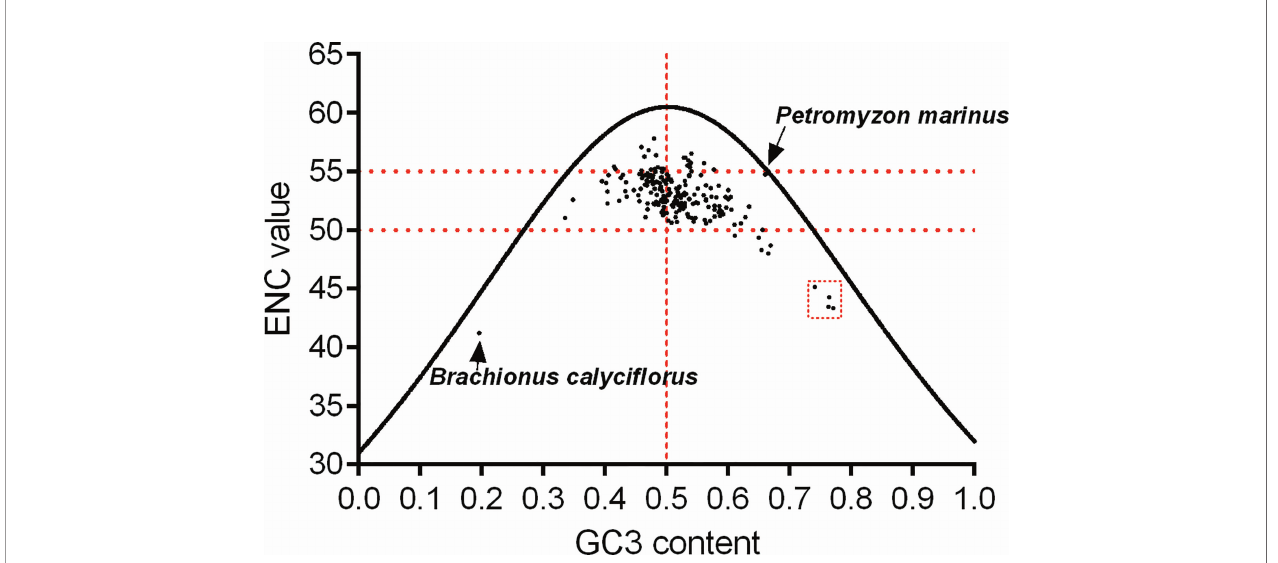
FIGURE 5 | The relationship between ENC and GC content at the third synonymous codon position (GC3) in atg13 genes of 226 eukaryotic organisms. The continuous curve line displays the expected codon usage if GC compositional constraints alone account for codon usage bias. The red broken lines highlight the distribution of agt13 genes in this plot of ENC vs. GC3 content. In addition, the red box with broken lines highlights the outliers which correspond to atg13 genes of the speci fi c organisms.